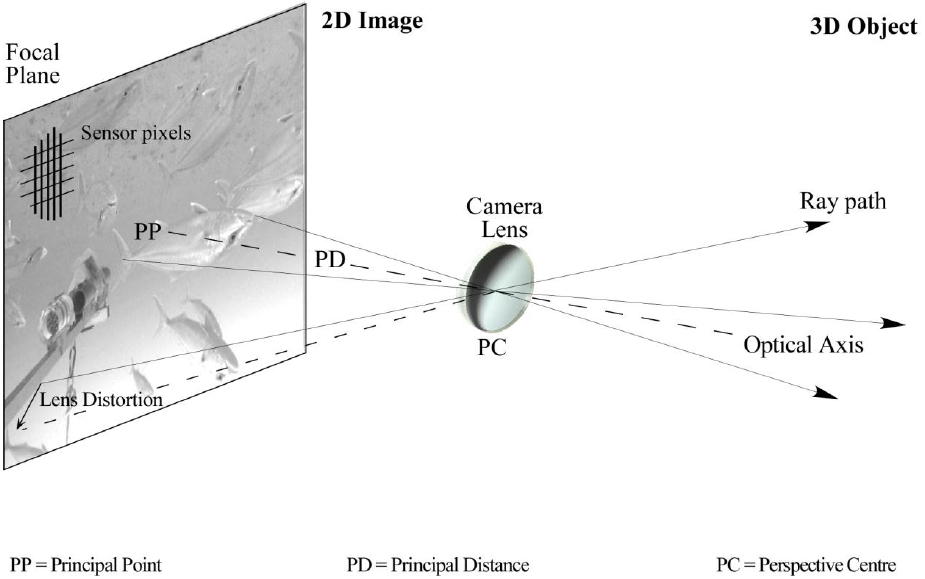
Figure 4. The geometry of perspective projection based on physical calibration parameters. Second, the relative orientation of the cameras with respect to one another, or the exterior orientation with respect to an external reference, must be determined. Also known as pose estimation, both the location and orientation of the camera(s) must be determined. For the commonly used